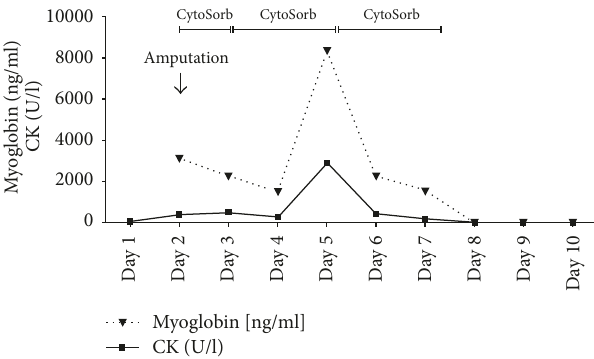
the course of the three Cytosorb sessions. Day 1 represents start of treatment after postoperative transfer to the ICU (CK: Creatin- Kinase).